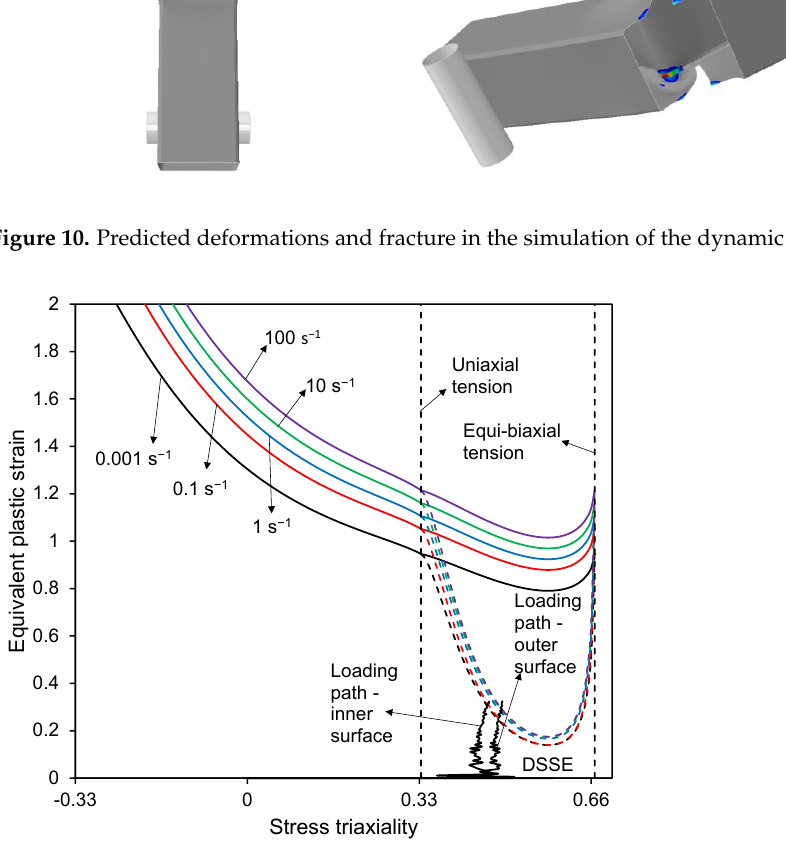
Figure 11. Loading paths of the top and bottom through-thickness integration points in the first failed